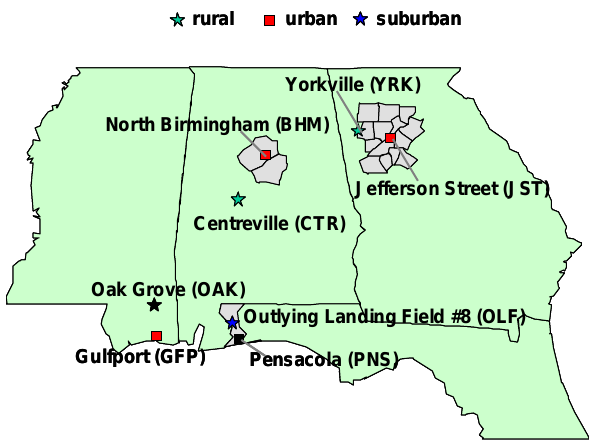
Figure 1. Geographical locations of the SEARCH monitoring sites 1. Geographical locations of the SEARCH monitoring sites and the nominal region 1336 and the nominal region of influence for the site measurements. PNS, of influence for the site measurements. PNS, OAK, GFP were retired after 1337 2009, 2010, 2012, respectively. The grey areas in the figure represent the 1338 OAK, and GFP were retired after 2009, 2010, 2012, respectively. counties corresponding to the urban metropolitan areas of Birmingham, Atlanta 1339 The grey areas in the figure represent the counties corresponding to the urban metropolitan areas of Birmingham, Atlanta and Pen- sacola,